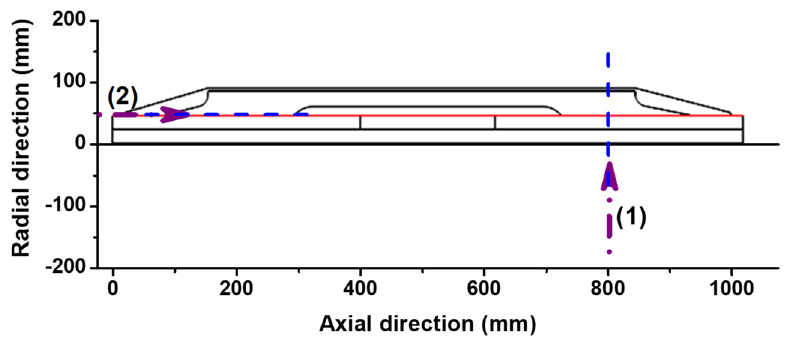
Figure 3. Dimensions of the joint and positions of the simulated field profiles indicated by arrows: (1) radially at a position z = 800 nm at mid-distance between the outer cone and central deflector; (2) axially: along the interface between the two insulators.